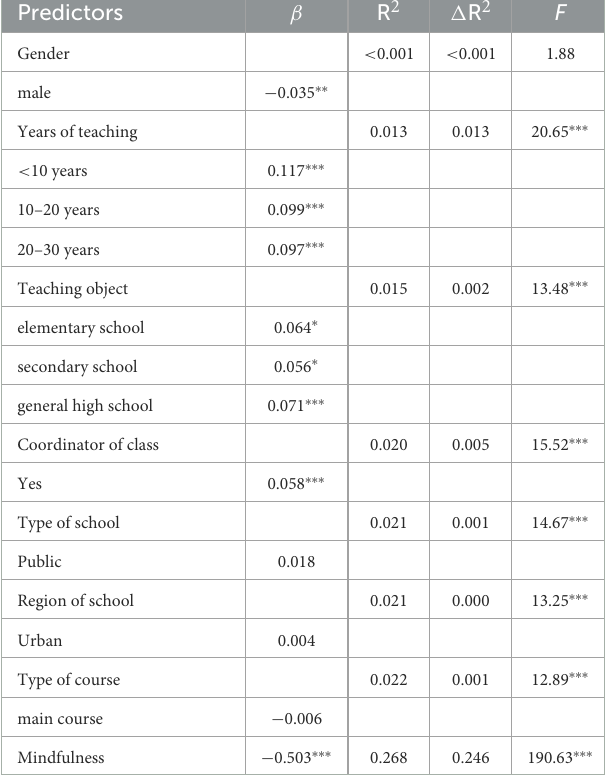
TABLE 4 Hierarchical regression for demographic variables and mindfulness trait predicting perceived stress level.